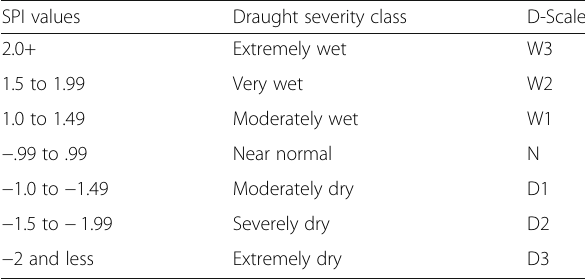
Table 1 Precipitation excess (wet) or deficit (dry) severity class according to SPI values and corresponding